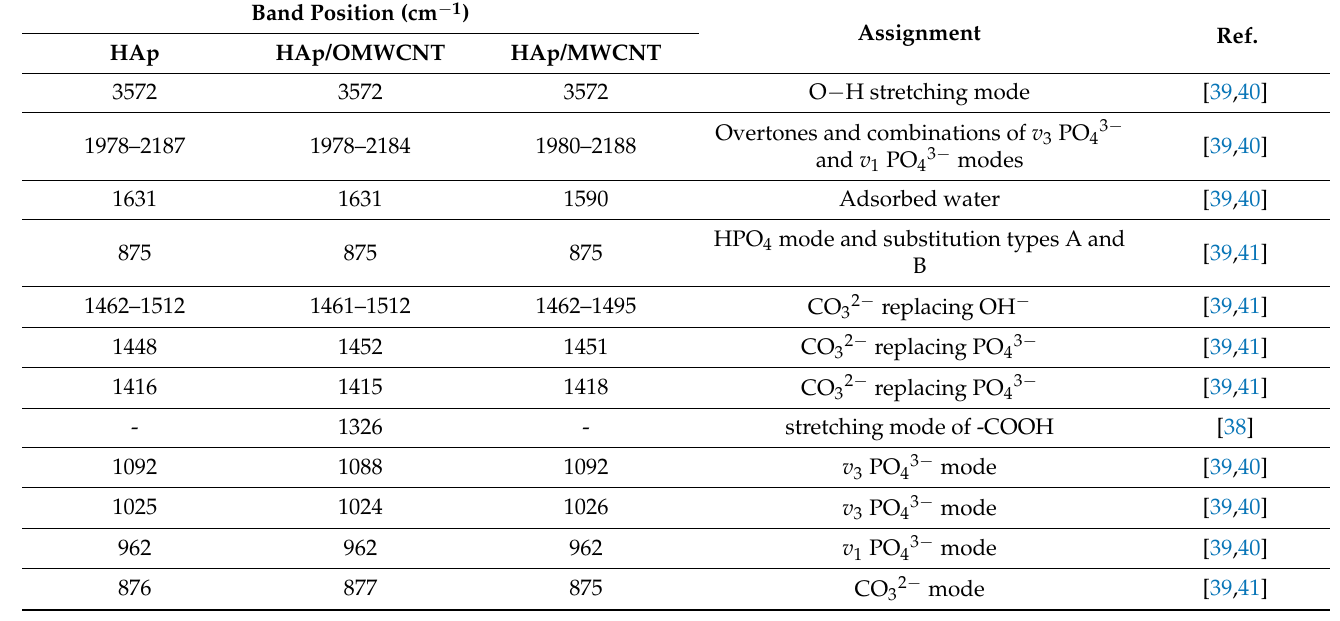
Table 2. Position and assignment of the vibrational modes of the HAp and composite samples.